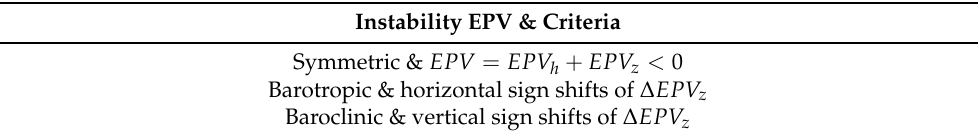
Table 2. Summary of the eventual instabilities related to the eddies.